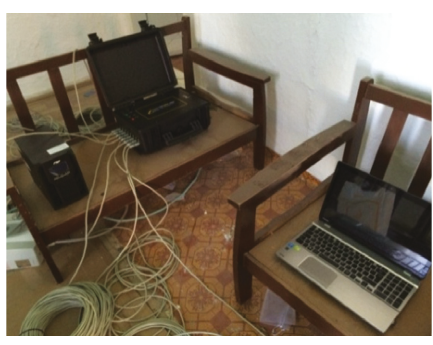
Figure 7: The sensor placements and test equipment.